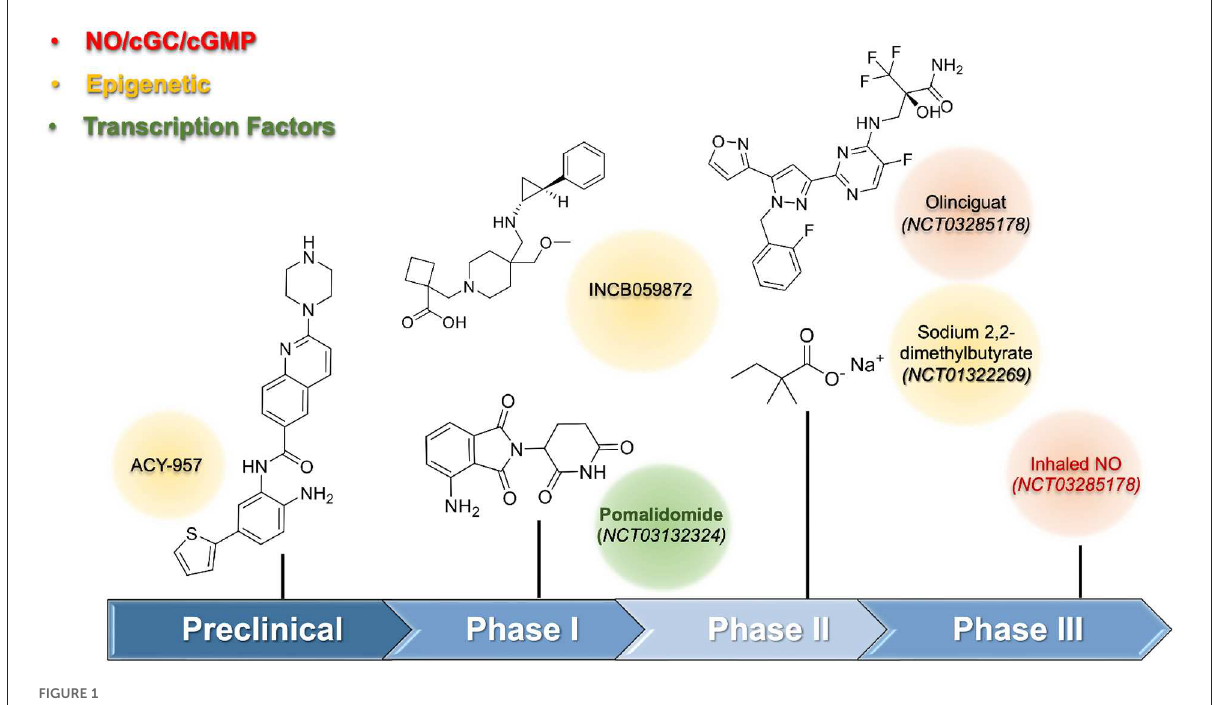
FIGURE1 Emerging HbF inducers for Sickle Cell